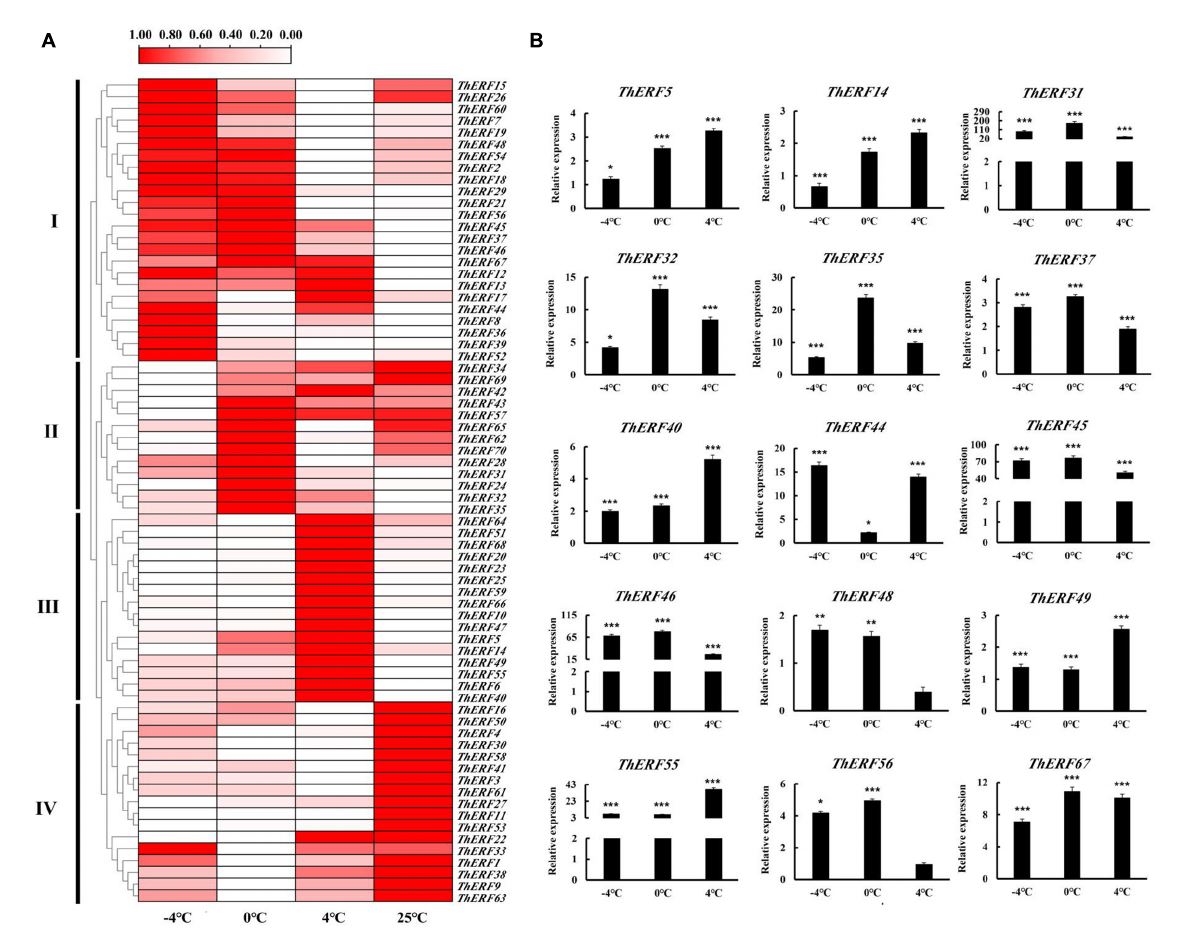
FIGURE3 Expression profiles of AP2/ERF TFs at (–4, 0, and 4 ◦ C) cold treatments. (A) Heat map for gene expression of 70 ThERFs in T. hemsleyanum under cold treatments. (B) Gene expression of 15 key ThERFs in T. hemsleyanum under cold treatments. The heat map is constructed based on the Log2 (relative expression level of each transcription factor) detected by qRT-PCR. The color scale represents the Log2 (relative expression level of each transcription factor), with white denoting low expression and red denoting high expression. Data are means ± standard error of the three biological replicates for each treatment. * P ≤ 0.05, ** P ≤ 0.01, *** P ≤